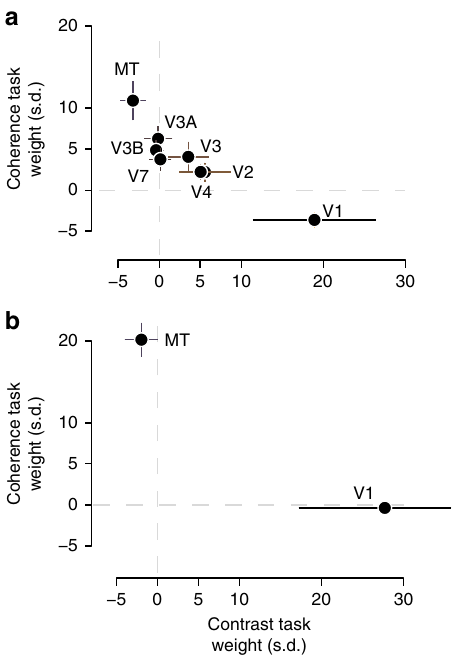
Fig. 5 Cortical area weights. a The weights of the fl exible-readout model fi t to passive viewing data are shown for the contrast task ( x axis) and coherence task ( y axis) for the eight cortical areas we de fi ned retinotopically: V1, V2, V3, V4 (hV4), V3A, V3B, V7, and MT (hMT + ). b As in a but for the two-area model with only V1 and MT. All markers indicate the mean across observers and error bars the 95% con fi dence